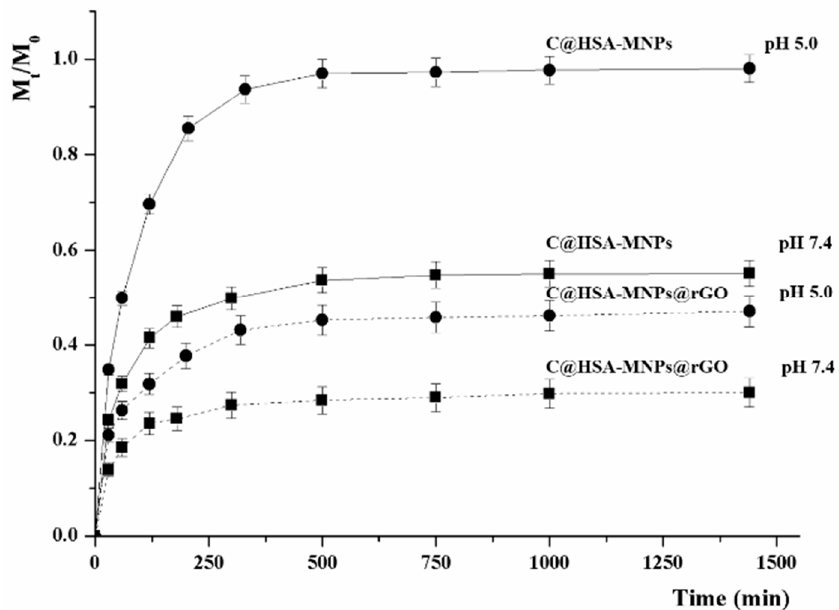
Figure 6. pH-responsive DOX release profile (Mt/M0) from C@HSA-MNPs (solid line) and C@HSA-MNPs@rGO (dashed lines) at pH 5.0 ( ● ) and 7.4 ( ■ ).